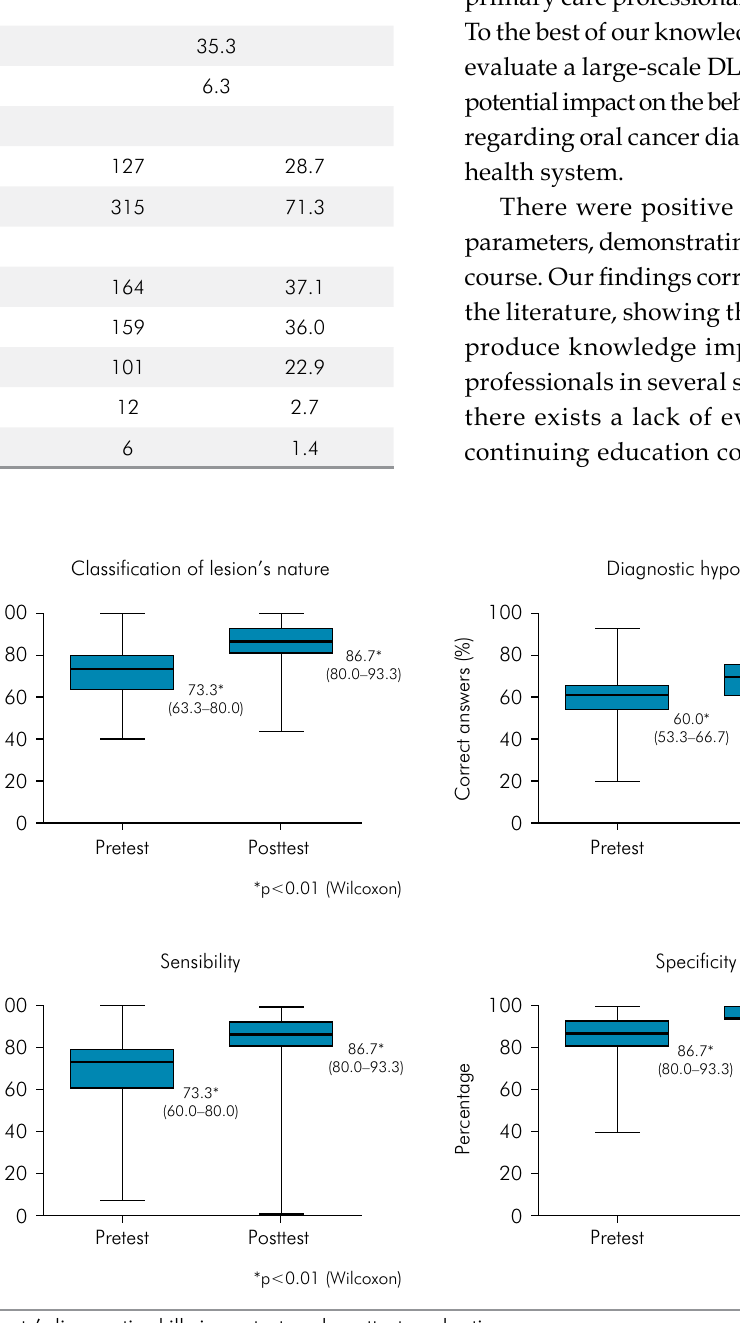
Figure 2. Participants’ diagnostic skills in pretest and posttest evaluation.